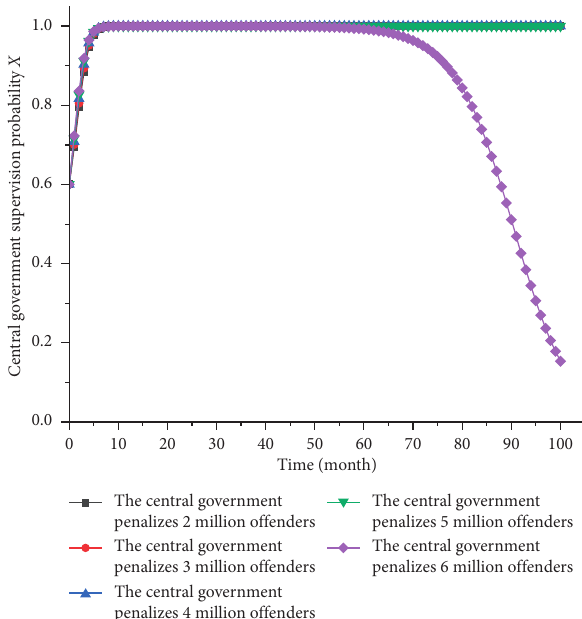
Figure 9: Impact of central fines on central government strategy